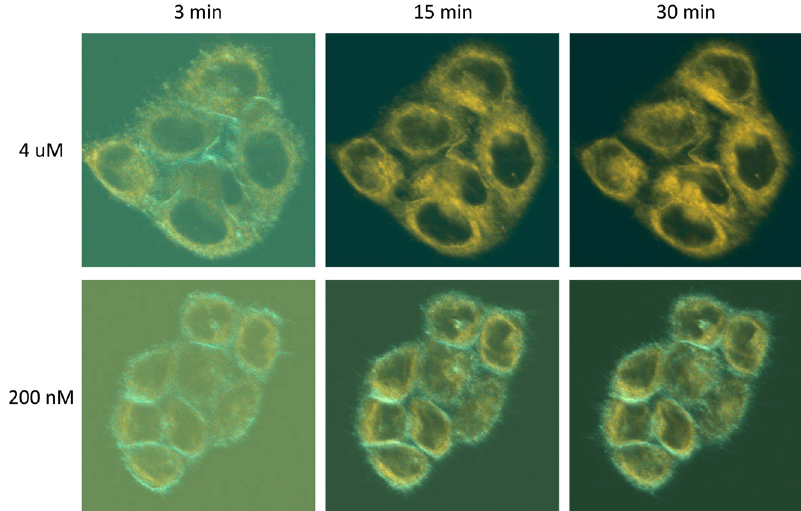
Figure 7. High concentrations of C-laurdan can result in autoquenching at the plasma membrane. Hela cells growing on coverslips were placed in observation chambers in 1 ml of serum-free medium and placed in the thermostatic chamber of the biphoton microscope. After focusing on a chosen group of cells, C-laurdan was added to a final concentration of either 4 µM (top panels) or 200 nM (bottom panels). Lambda stack images were then taken at the indicated times, with the laser power set at 2% for staining with 4 µM, and 4% for 200 nM C-laurdan. All other settings were as described in Methods and spectral decomposition was carried out as described in Methods. The pictures shown are dual-colour overlays. Cyan, C-laurdan in apolar environments; orange, C-laurdan in water-exposed environments. The duller aspect of the pictures taken at 3 minutes is due to the fact that, at this early time point, the probe had not had time to stain the cells fully, resulting in low signal to noise ratios.